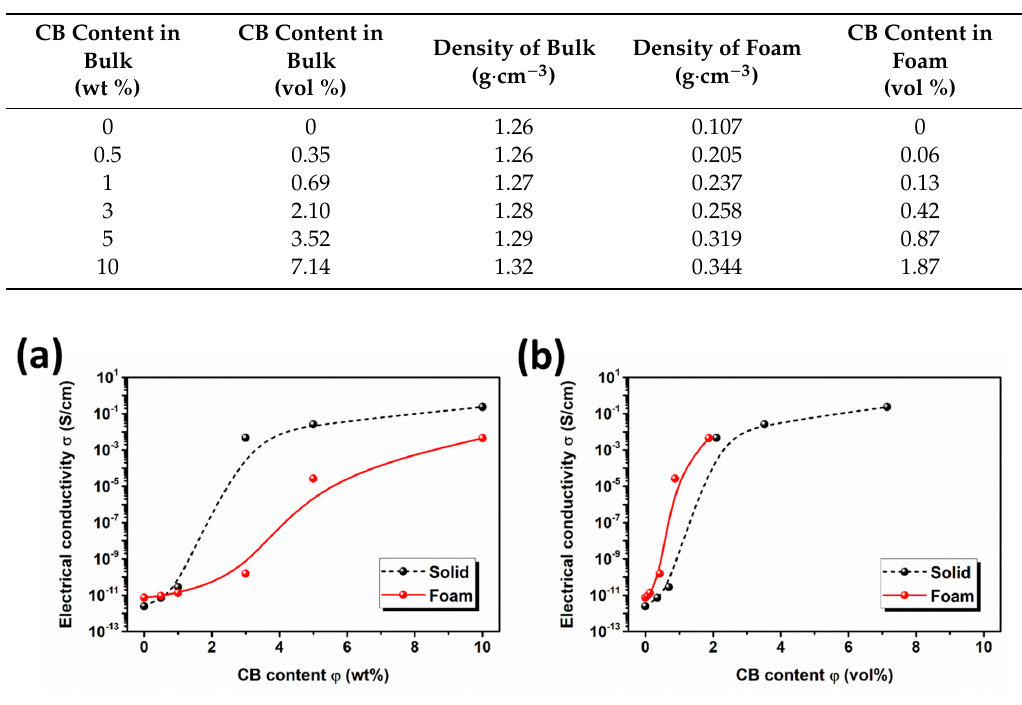
Figure S1: CB particles aggregation size distribution in PBS / CB nanocomposites: (a) PBS0.5, (b) PBS1, (c) PBS3, (d) PBS5, (e) PBS10., Table S1: Summary of the DSC results for PBS / CB